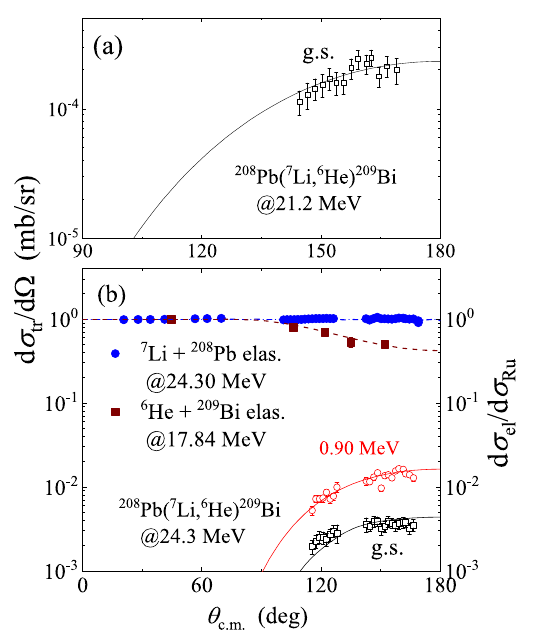
Figure 1. (Color online) Angular distributions of 208 Pb( 7 Li, 6 He) reactions for proton transferred to di ff erent states of 209 Bi at E lab = 21 . 20 (a) and 24.30 (b) MeV, respectively. The experi- mental results are labelled according to the the excitation energy of 209 Bi. The solid curves represent the CRC fitting results. The elastic scattering of the entrance channel 7 Li + 208 Pb E lab ( 7 Li) = 24.30 MeV as well as that of the corresponding exit channel 6 He + 209 Bi at E = 17 . 84 MeV [15] are also shown by the solid cir- lab cles and squares, respectively. The dash-dotted curve is the CRC fitting result and the dashed curve represents the calculation re- sult with the OMP extracted from the transfer